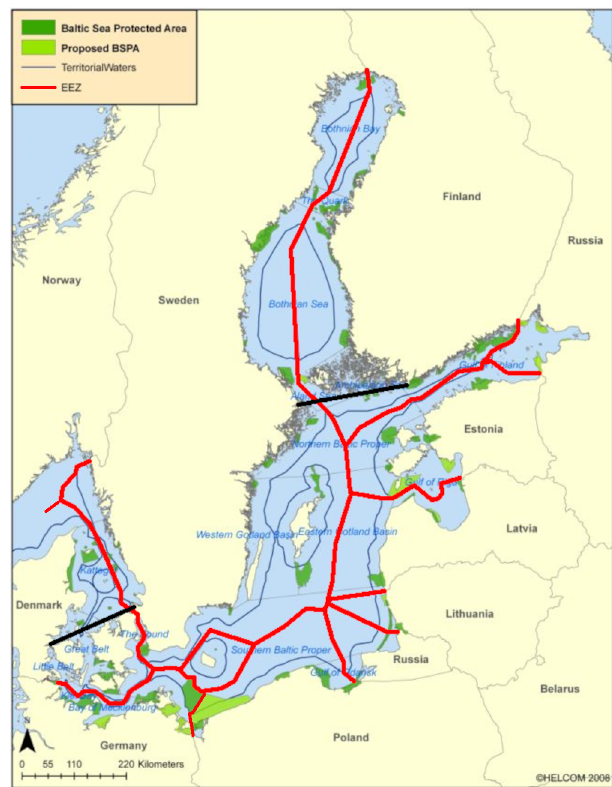
Figure 2. The Baltic Sea and location of its sub-basins. The blue line shows the border of territorial waters (12 nautical miles) and the purple lines indicate the exclusive economic zones. Black thick lines show the boundaries between different areas used to define antifouling classes in Table 3. Green colour indicate existing (dark green) and proposed (light green) protected areas. Image from HEL- COM, Baltic Sea protected areas map,